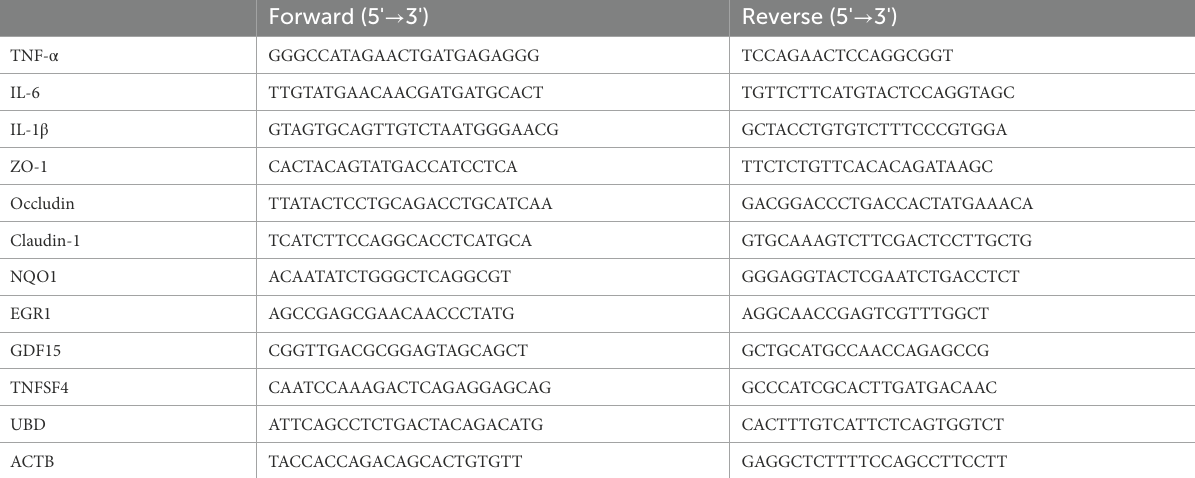
TABLE 1 Sequences of primers for